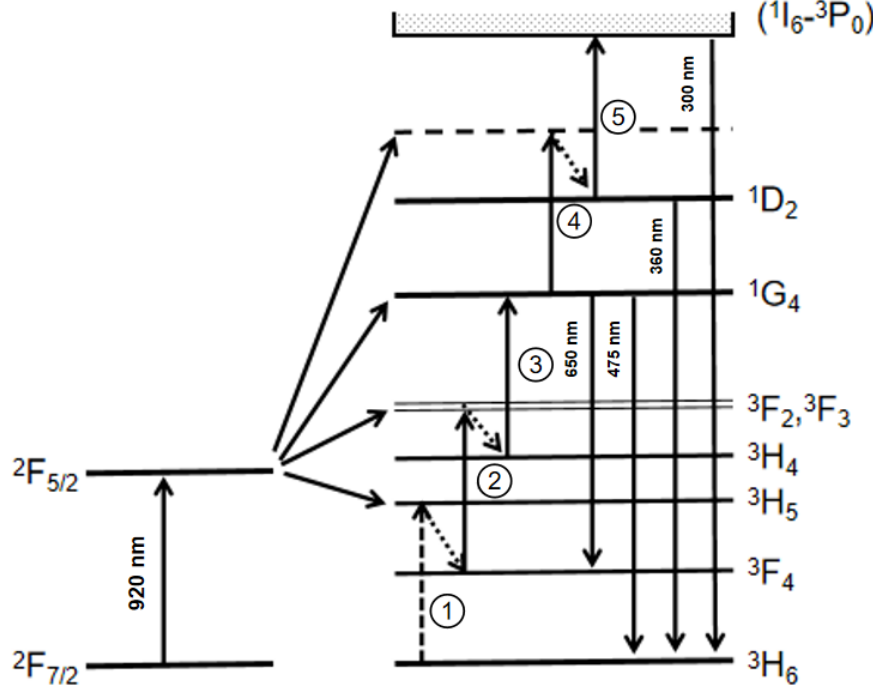
Figure 5. Schematic diagram of Yb 3+ and Tm 3+ energy levels in fiber.